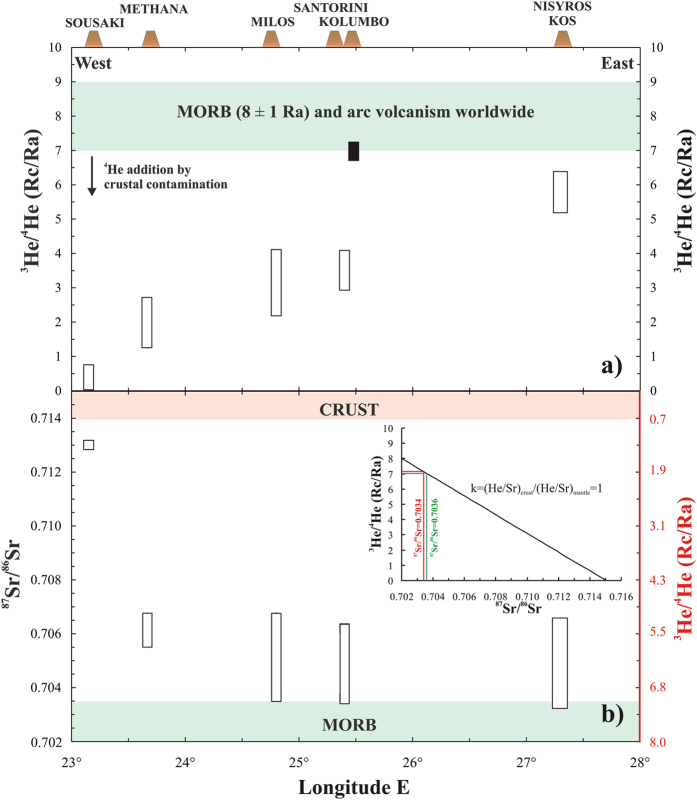
Along-arc variations of (a) 3He/4He41734424344 and (b) 87Sr/86Sr ratios in the HVA15164647. Solid black rectangle in plot 4a reproduces the range of He isotope ratios of Kolumbo gases. In the insert diagram of plot 4b we report a binary mixing between a MORB-like mantle (3He/4He = 8.0 Ra; 87Sr/86Sr = 0.7020) and a hypothetical Aegean continental crust (3He/4He = 0.03 Ra; 87Sr/86Sr = 0.7150)5051. See text for further details. Based on this mixing, the secondary y axis of plot 4b reports the expected 3He/4He ratios (red coloured) corresponding to the 87Sr/86Sr ratios reported in the left y axis.